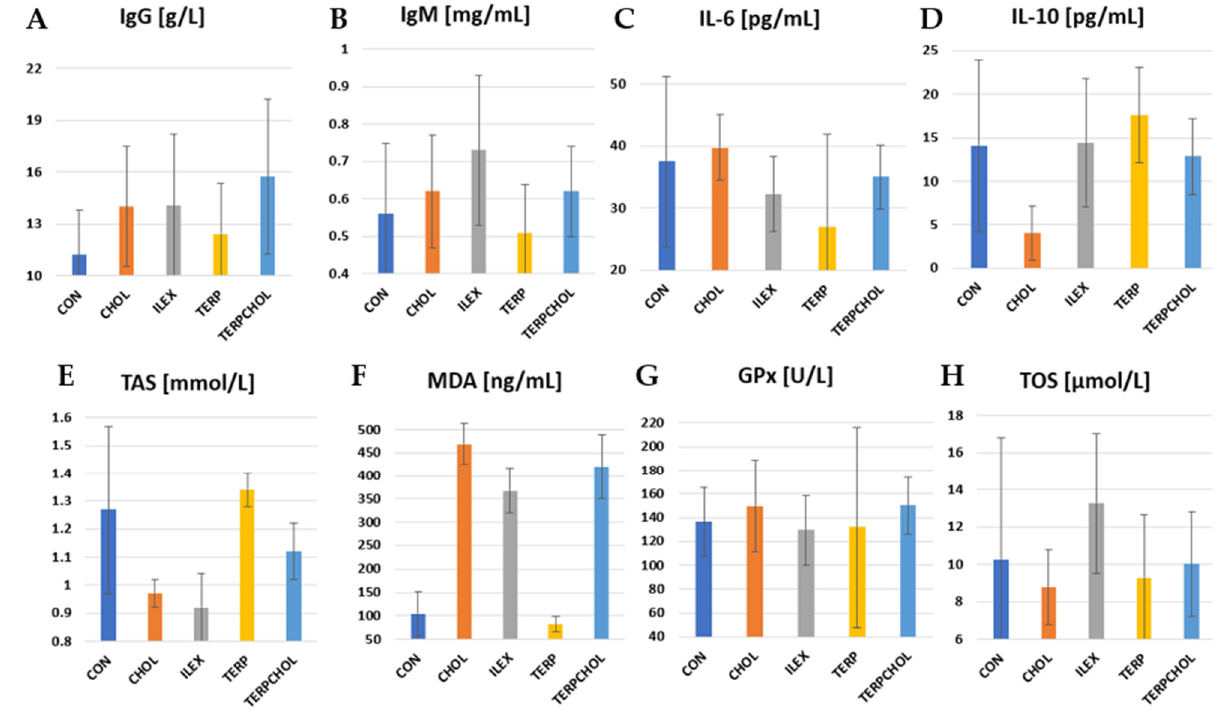
Figure 4. Levels of ( A ) IgG; ( B ) IgM; ( C ) IL-6; ( D ) IL-10; ( E ) TAS; ( F ) MDA; ( G ) GPx, and ( H ) TOS in CON, CHOL, ILEX, TERP, and TERPCHOL